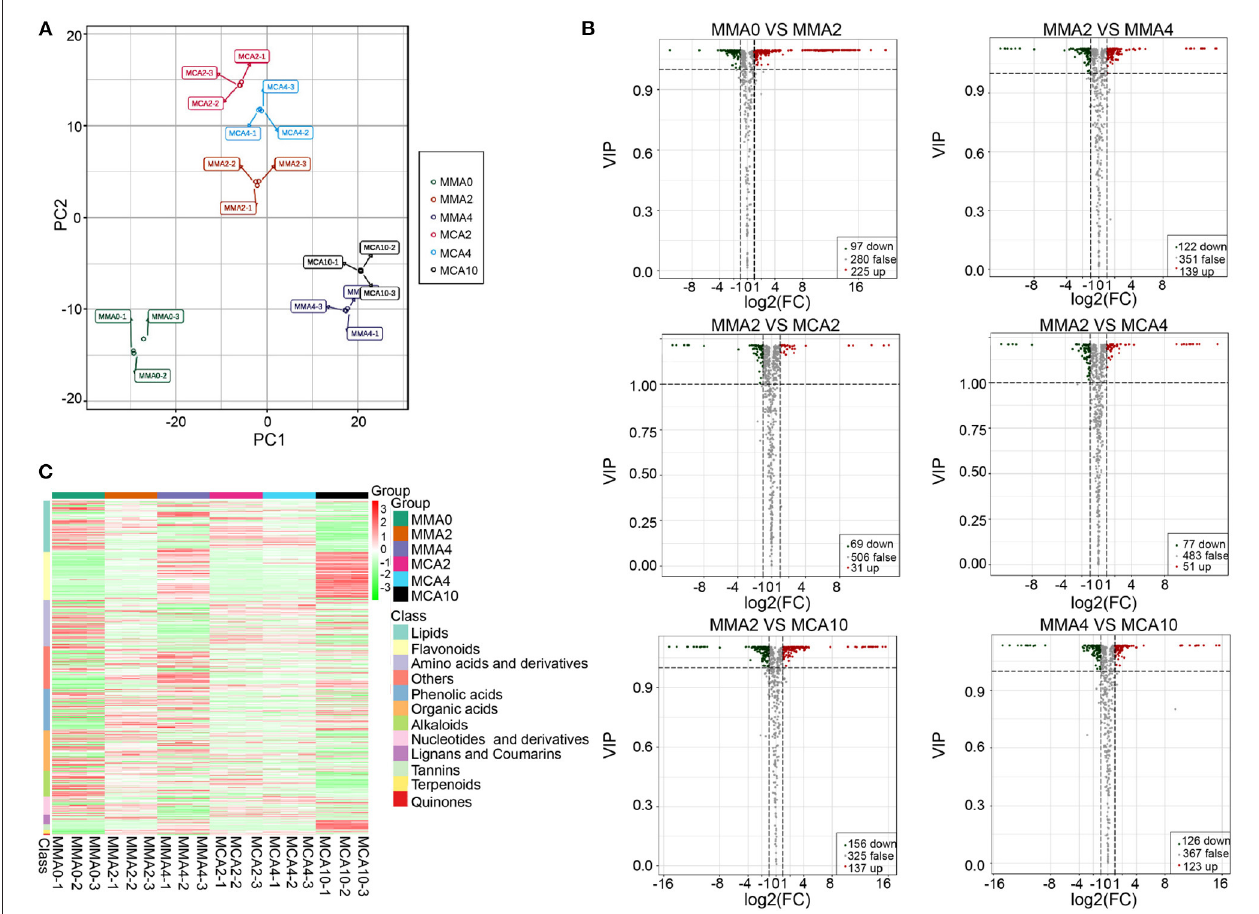
FIGURE 3 | Metabolome analysis. (A) Score plot of the principal component analysis. (B) Volcano plot of the significantly different metabolites. (C) Heatmap of the significantly different